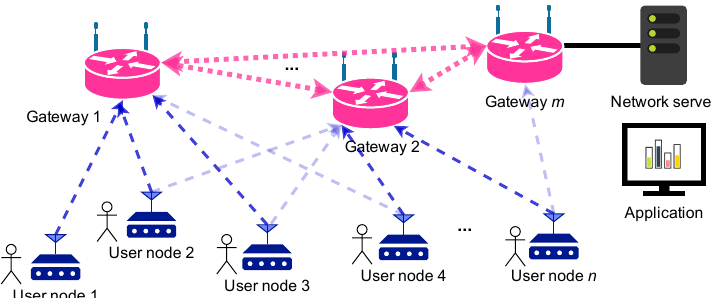
Figure 1. High-level depiction of the system architecture, matching the LoRaWAN